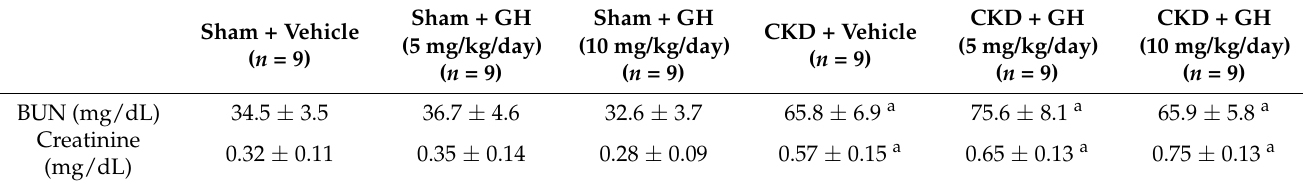
Table 1. Serum and blood chemistry of mice from ad libitum study. Eight-week-old CKD and sham mice were treated with GH (5 mg/kg per day or 10 mg/kg per day) or normal saline as a vehicle for six weeks. All mice were fed ad libitum. Data are expressed as mean ± SEM. Results of all five groups of mice were compared to those of Sham + Vehicle mice, respectively. BUN, blood urea